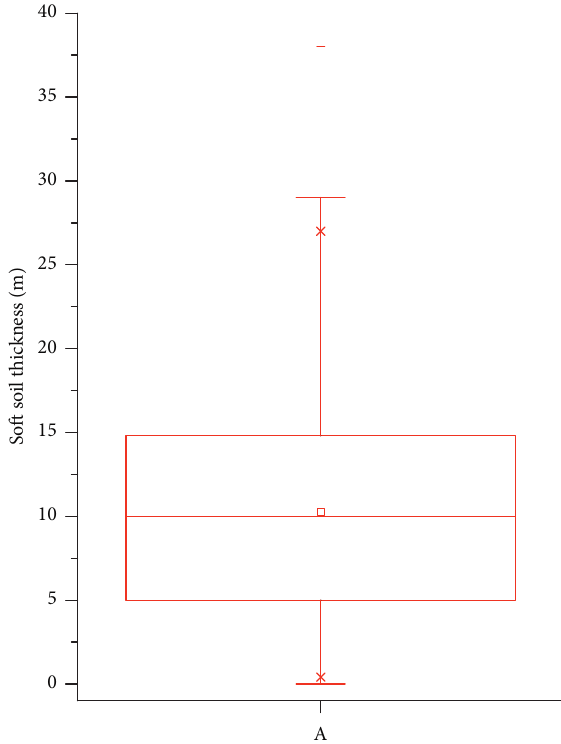
Figure 11: Statistical box diagram of the soft soil thickness along